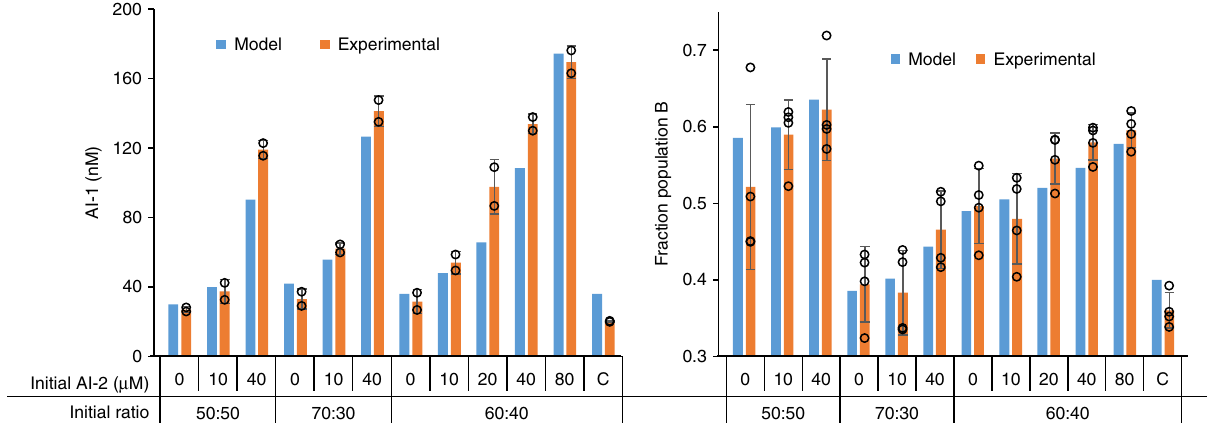
Fig. 6 Predicting co-culture behavior using mathematical model. Co-cultures of A and B were added to media containing varied AI-2 concentrations and samples for AI-1 (left) and co-culture composition (right) measurement were collected after 5 h. Both cell lines were inoculated from overnight cultures to a combined initial OD of 0.05. The initial ratio of A:B is indicated. The control “ C ” used PH04 pAHL-sfGFP instead of PH04 pAHL-HPr as Population B and used media with 0 µ M AI-2. Both model results and experimental results are shown. Error bars represent s.d. between technical duplicates (AI-1 measurements) and technical quadruplicates (composition measurements). Source data are provided as a Source Data fi